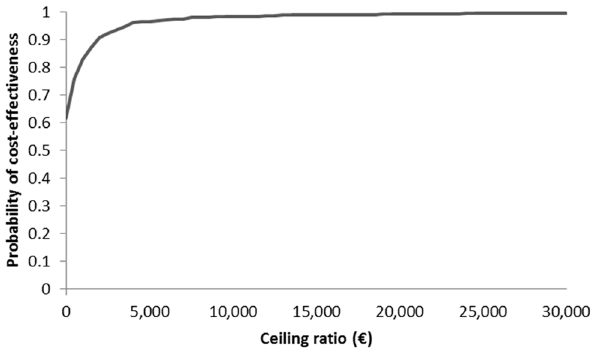
Fig 6. Cost-effectiveness acceptability curve in the base case analysis.